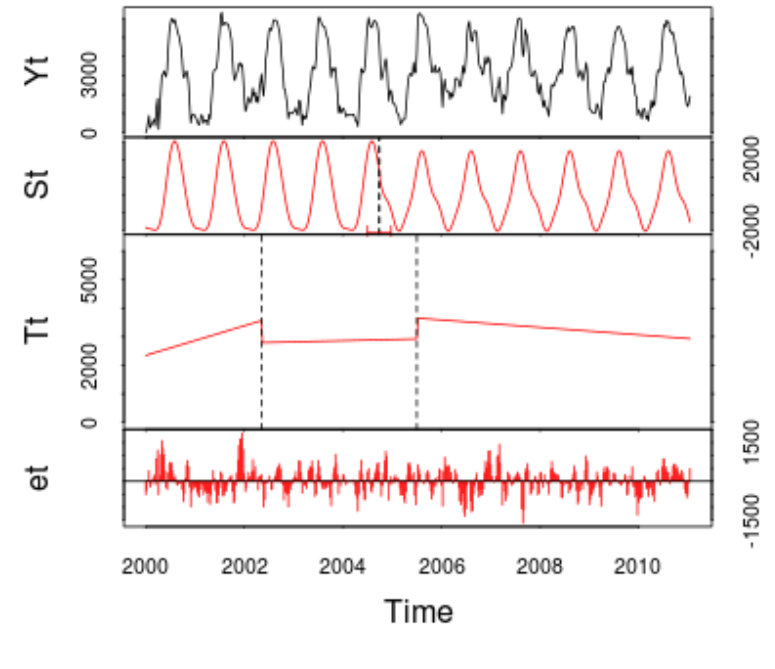
Figure 3. Fitted seasonal, trend, and remainder components for MODIS time series (2000–2010), generated by the breaks for additive seasonal and trend (BFAST) method. The dashed lines represent the dates of detected breakpoints, together with their confidential intervals